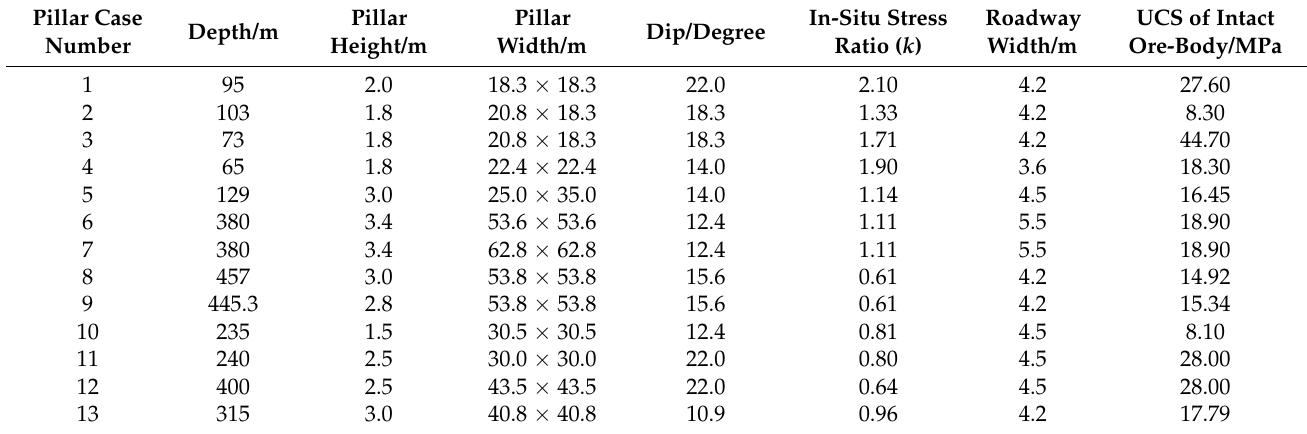
Table 2. Stable inclined pillar cases